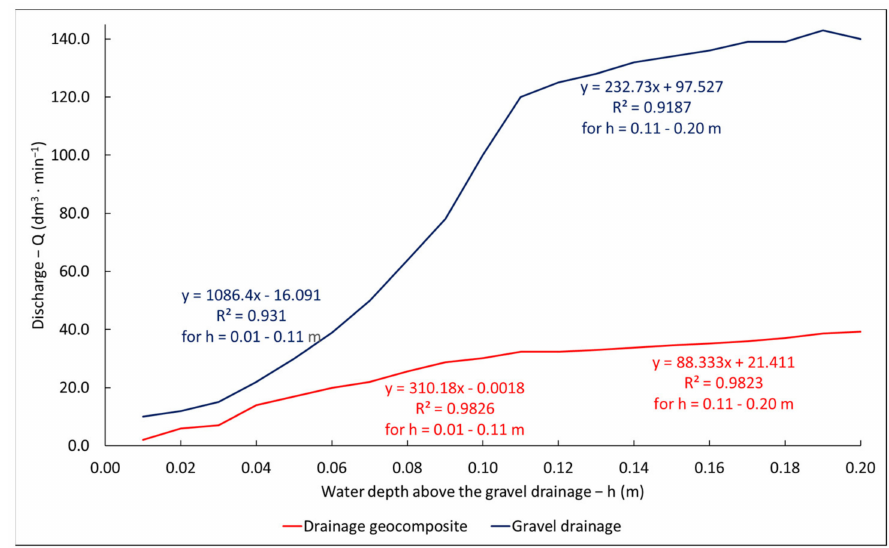
Figure 9. Influence of damming height on flow volume in the research